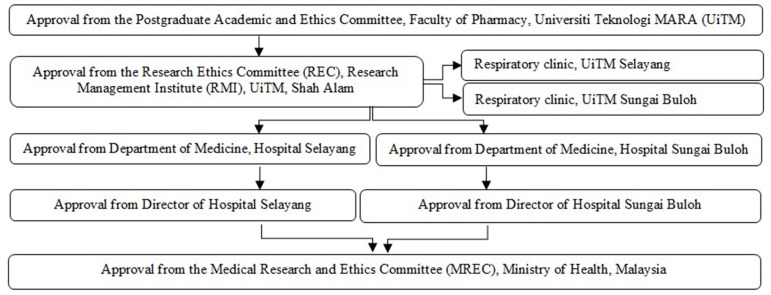
Ethical approval procedure.